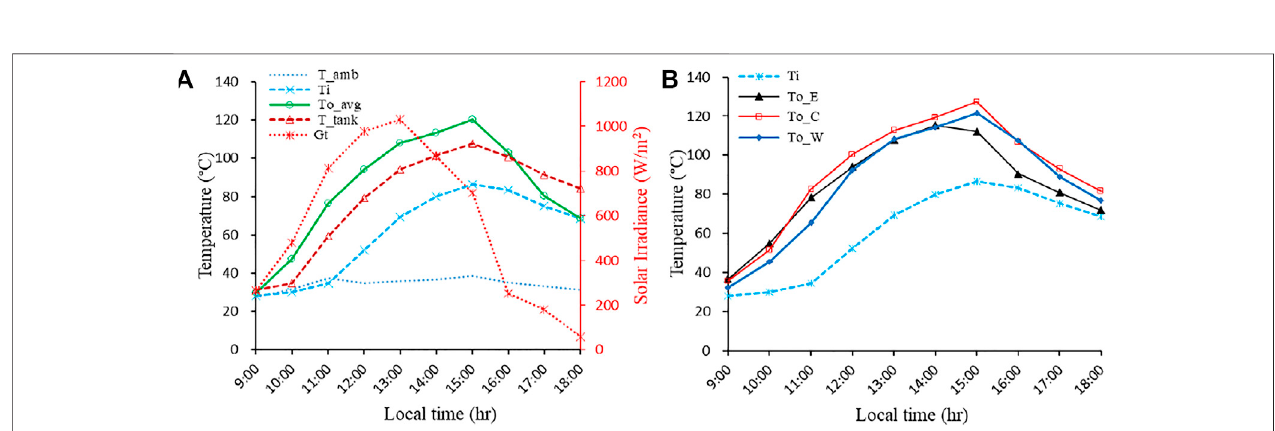
FIGURE 8 | Variation of hourly averaged temperatures using thermal oil under actual weather conditions on day-1 (A) average temperatures and solar irradiance, (B) inlet and outlet temperatures of individual receiver tubes.